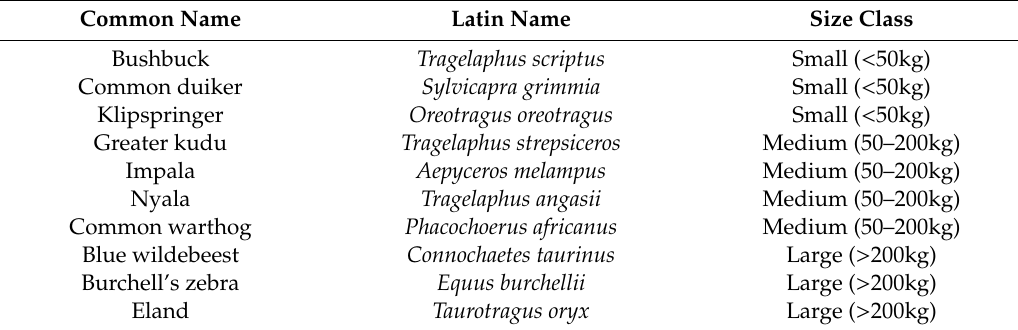
Table A2. Size classes of ungulates identified in brown hyaena and leopard diets that was used for broad diet assessments.